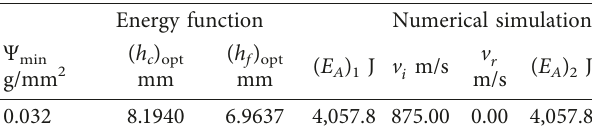
Table 10: Verification of the optimal combination. Energy